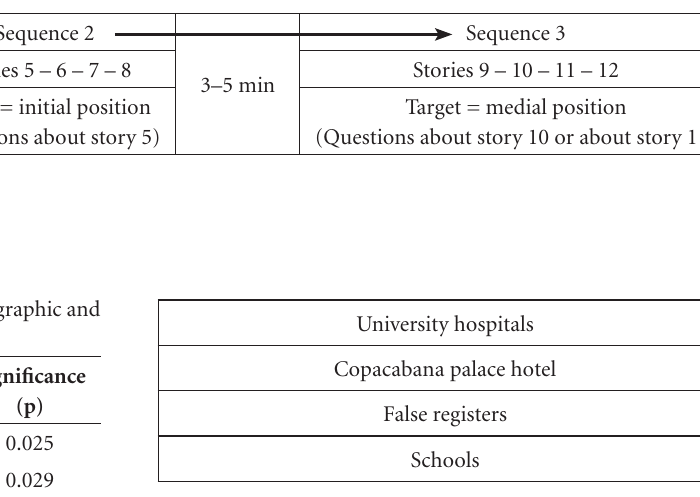
Figure 2. Example of key words in news item.